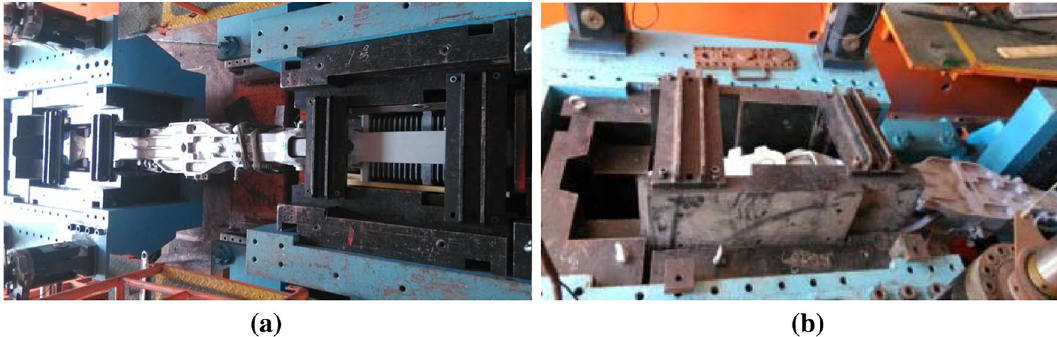
Fig. 5 Compressed stability test of coupler. a Illustration of test rig. b Coupler jackknifing